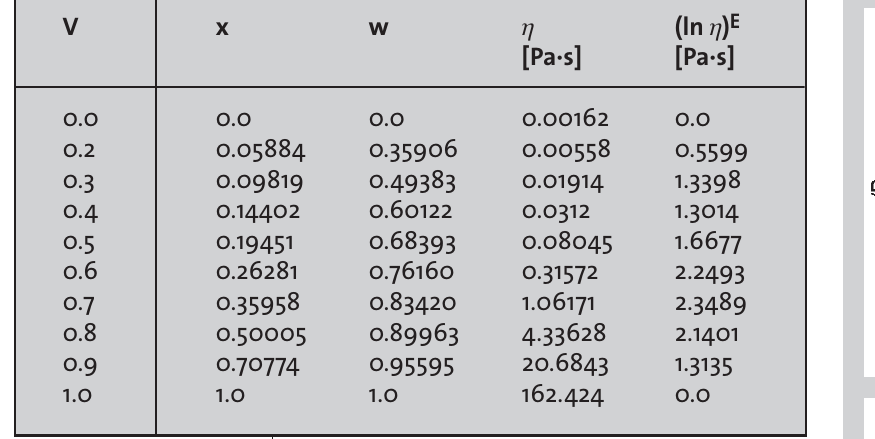
Table 2: Apparent viscosity (at 10 s -1 ) and excess logarithm viscos- ity for the binary mixtures NC H OH] + [Zn Cl ] - of [Me 3 2 4 2 5 + ()EtOH at 298.15K. x stands for mole fraction of RTIL. Figure 7 (above): Apparent viscosity plot as a function of the mole frac- tion of EtOH at shear rates of 3.98, 10 and 25.1 s -1 . The solid line represents the fit by Eq. 5. Figure 8: The excess logarithm vis- cosities for mixtures of NC H OH] + [Zn Cl ] - x [Me 3 2 4 2 5 + (1 - x) EtOH at 298.15